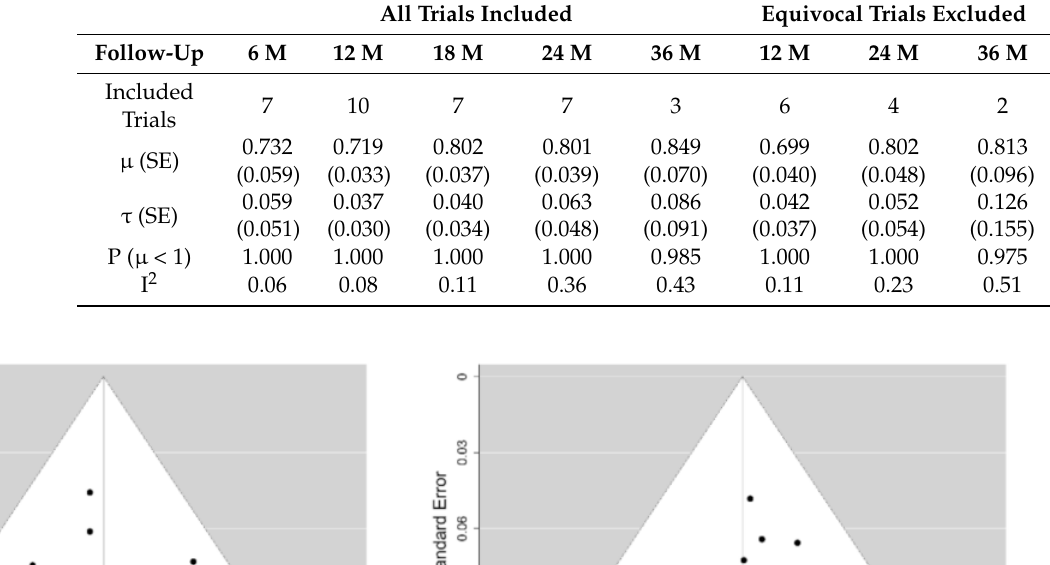
Table 4. The number of included trials, estimated values of µ , τ and their associated standard errors, the probability that µ is smaller than 1, and the values of relative heterogeneity at different time intervals with and without the 4 equivocal trials for the primary variable of the scaled sphere equivalent refraction progression.